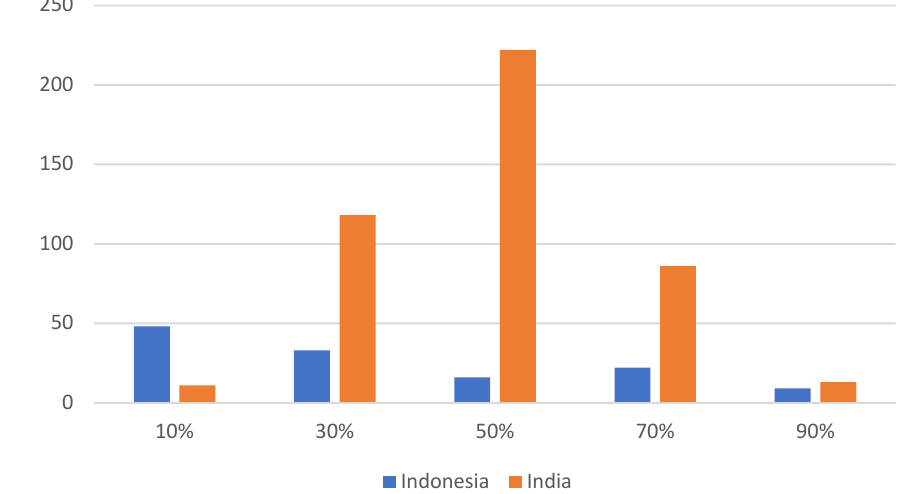
Figure 1. Results of Q9 (percentage of respondents’ close friends who believe in different religions). Sample sizes are n = 128 and 450 for Indonesia and India, respectively.